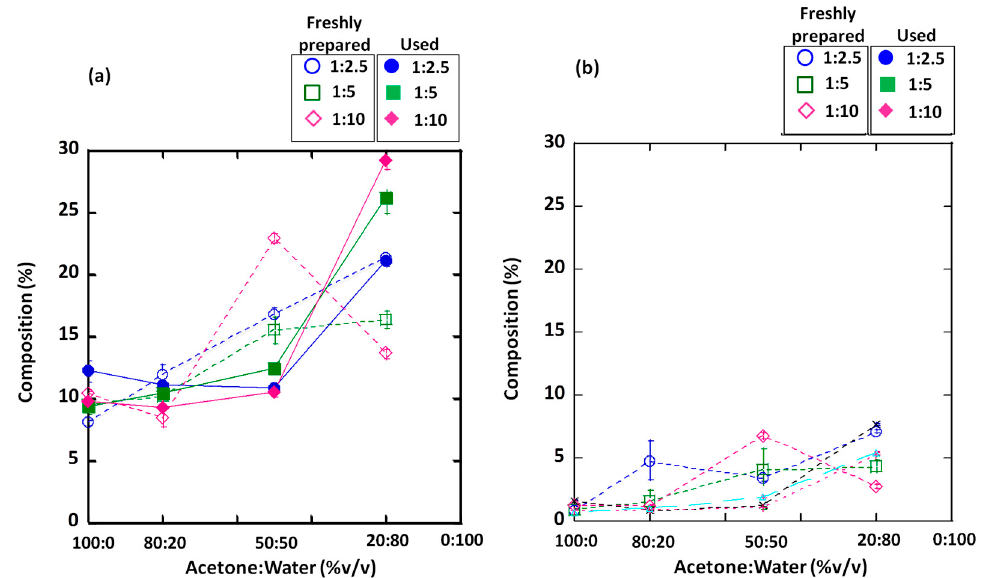
Figure 5. Composition of ( a ) CaO and ( b ) SO 3 in cenospheres collected from fly ash, using different acetone / water ratios, a 4-h soaking period, and fly ash / medium ratios of 1:2.5, 1:5, and 1:10. Data of the freshly prepared and the reused mixtures are presented for comparison.